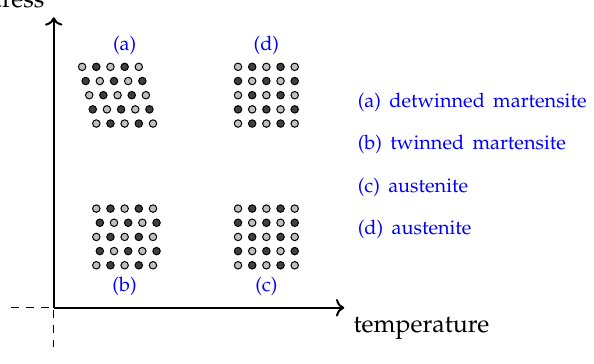
Figure 3. Stress–temperature plane showing schematic crystal structures of the different phases of a typical SMA .